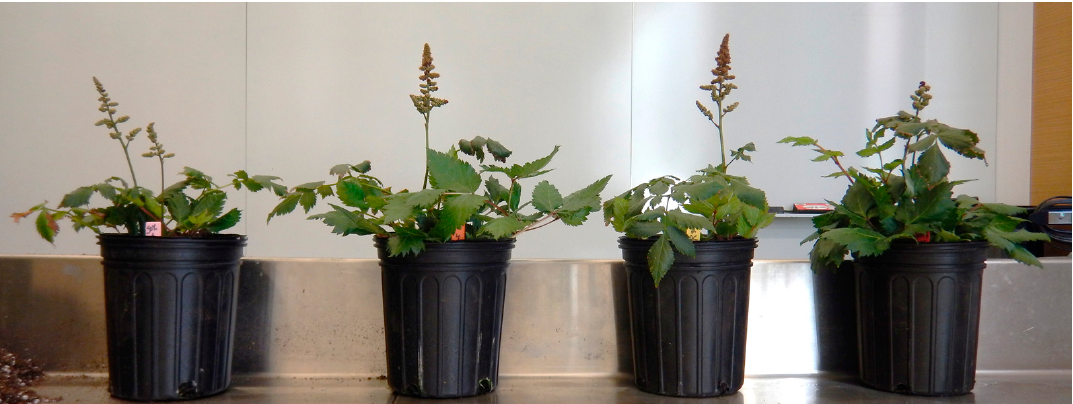
Figure 1. Representative plants of ‘Visions’ astilbe at the conclusion of the 61 day experiment. Plants were maintained at either 40% VWC or 18% VWC and received either 100% (12 g/plant) or 50% (6 g/plant) of the medium bag rate of controlled release fertilizer. Treatments were 18% VWC 50% (6 g/plant) CRF, 40% VWC 50% CRF, 18% VWC 100% CRF, and 40% VWC 100% CRF (left to right).